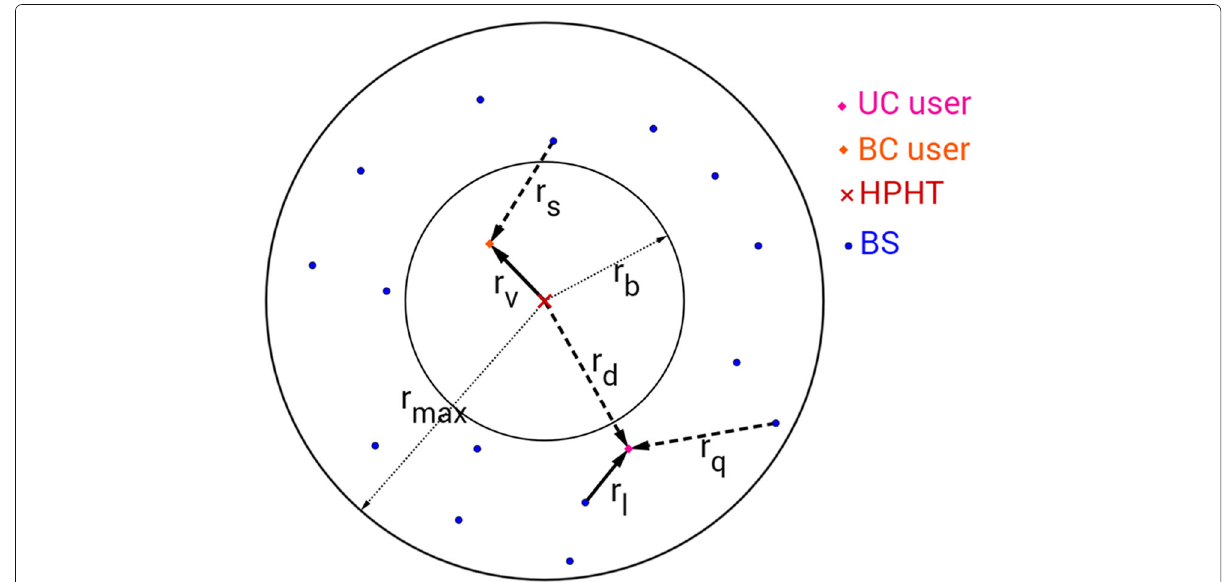
Fig. 3 Important distances used in the model